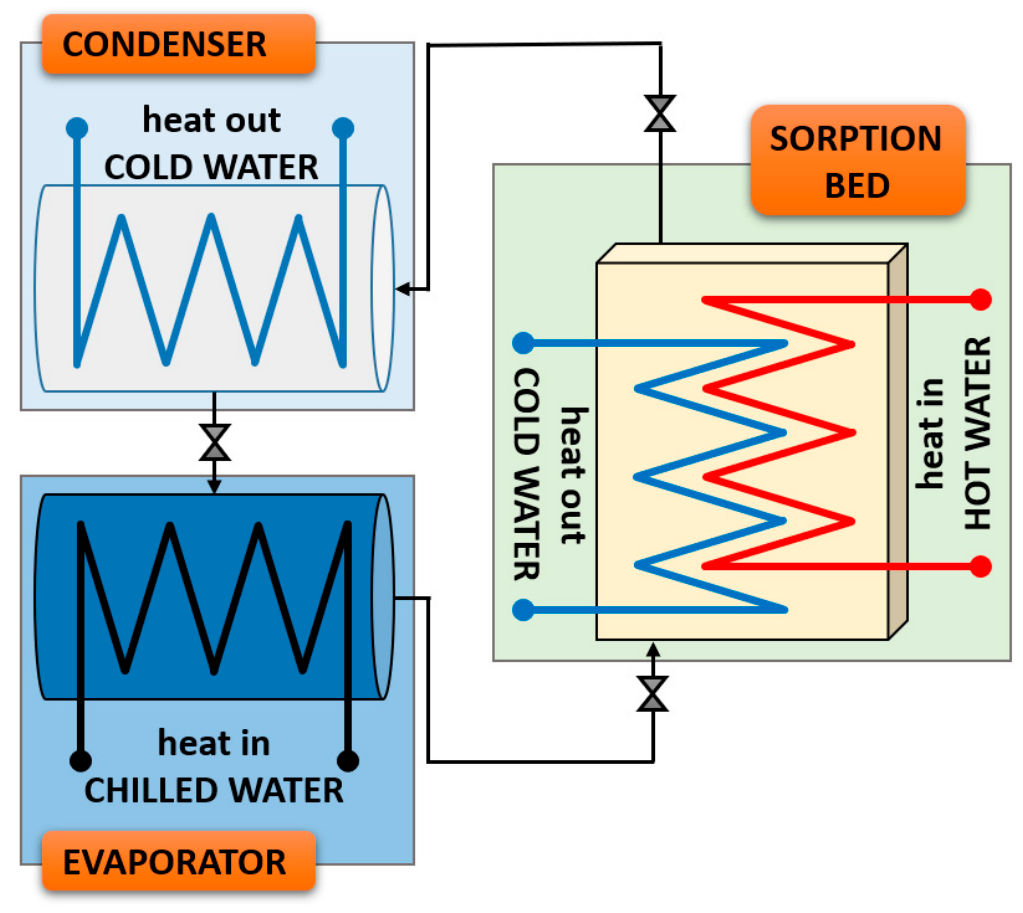
Figure 1. Scheme of adsorption chiller.